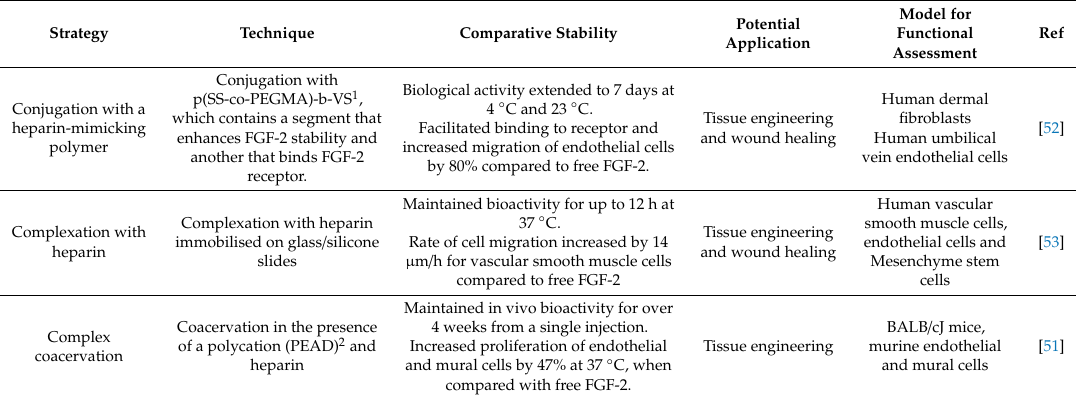
Table 1. Examples of aqueous environment modification techniques, which have demonstrated increased stability and / or bioactivity of the modified fibroblast growth factor (FGF)-2 compared with the unmodified